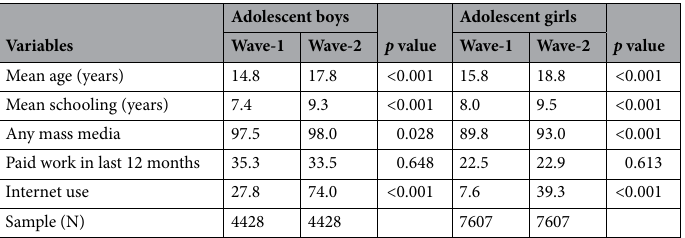
Table 2. Summary statistics for explanatory variables used in the analysis of UDAYA wave-1 and